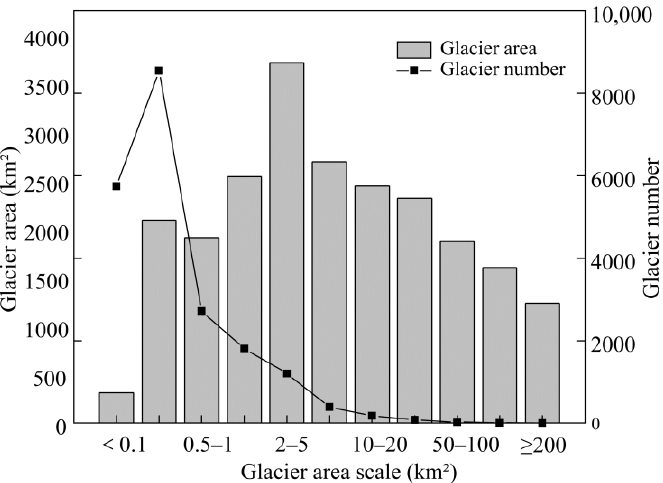
Figure 2. Number and area of glaciers in different scales in Xinjiang. Table 2. The glacier resources in different mountains in Xinjiang.